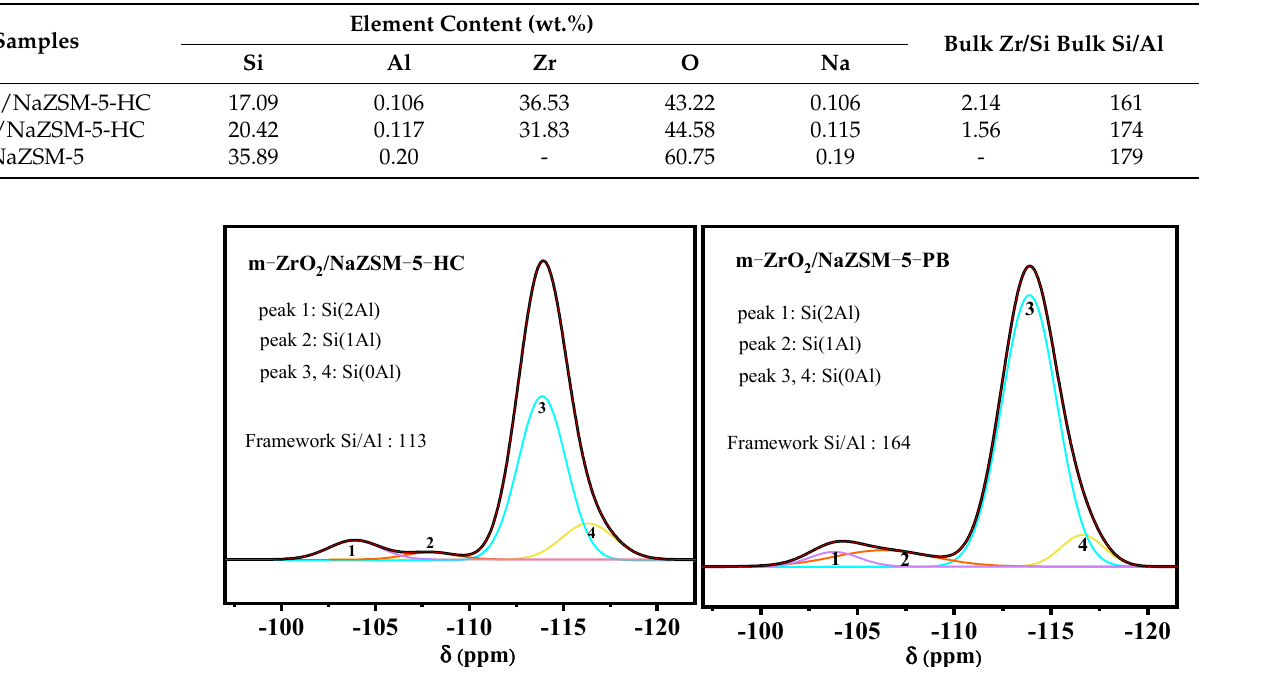
Figure 3. 29 Si NMR spectra of m-ZrO 2 /NaZSM-5-HC and m-ZrO 2 /NaZSM-5-PB composite catalysts.